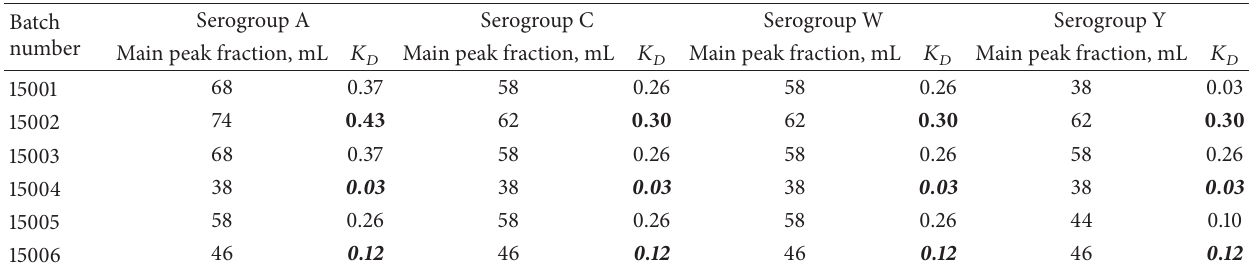
Table 1: Main peak fraction volumes and corresponding 𝐾 𝐷 values of six batches of Ingovax ACWY vaccine (the highest 𝐾 𝐷 values were indicated as bold and lowest ones as bold italic letters).